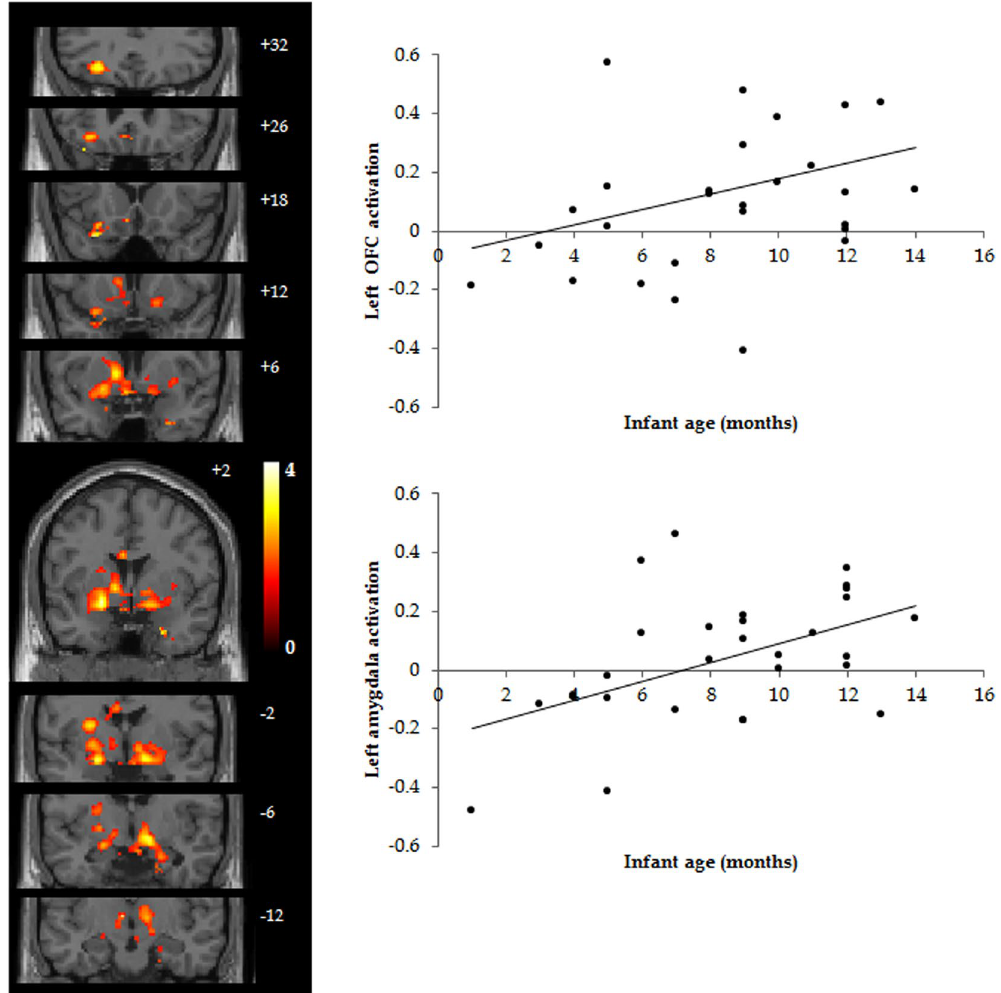
Figure 2. Motherhood has a ‘dose-dependent’ effect on the processing of basic infant emotional signals. Infant age was significantly correlated with mothers’ differential reactivity to infant and adult vocalisations in a cluster encompassing left amygdala and left OFC (main effect of age; infant > adult vocalisations; regression analysis; p < 0.05, cluster-FWE correction). Scatter plots display parameter estimates from significant clusters for left OFC (upper) and left amygdala (lower). These regions of interest were defined as 6 mm-radius spheres centered on peak coordinates identified in the whole-brain